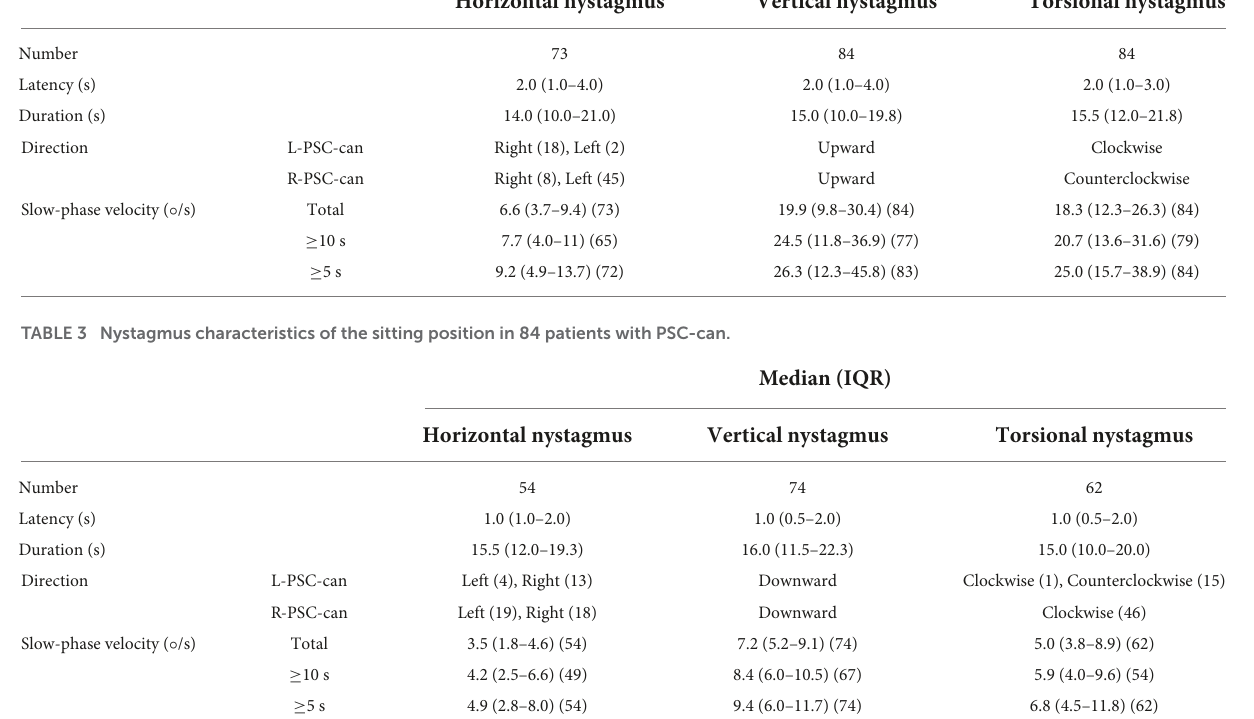
TABLE 2 Nystagmus characteristics of the head-hanging position in 84 patients with PSC-can.